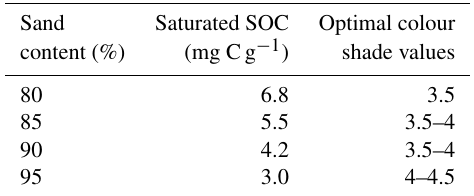
Table 8. Calculated soil organic carbon content (SOC) of 80%-C- saturated soil for various sand contents using Feng et al. (2013) and the estimated colour shade value (Blume et al., 2011, p. 51). Sand Saturated SOC Optimal colour content